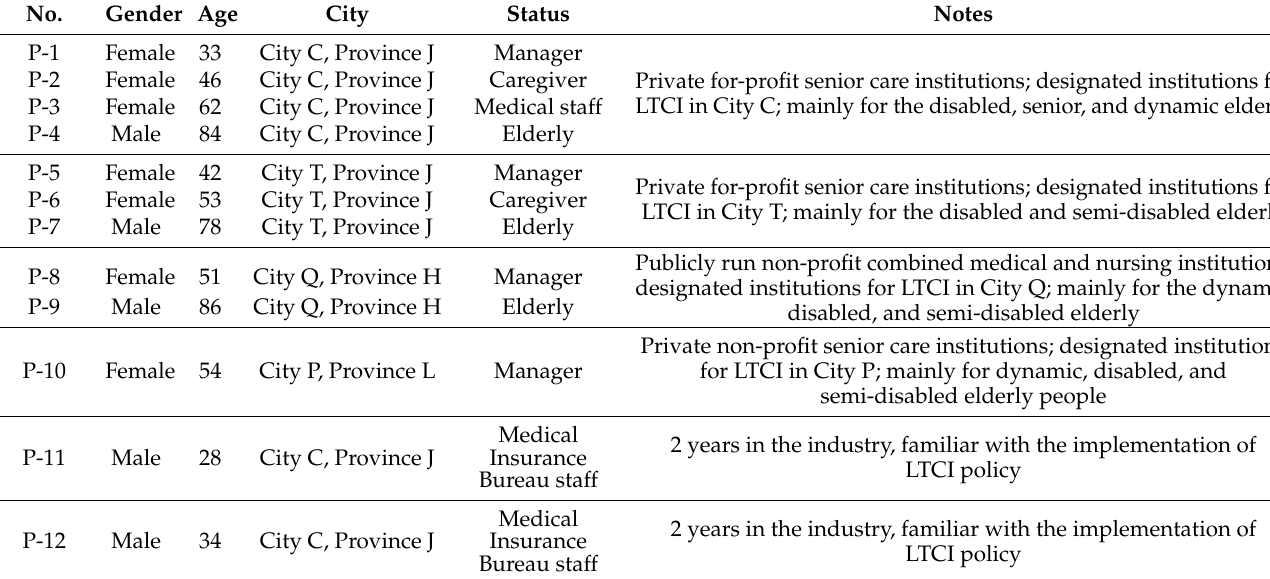
Table 1. Description of research